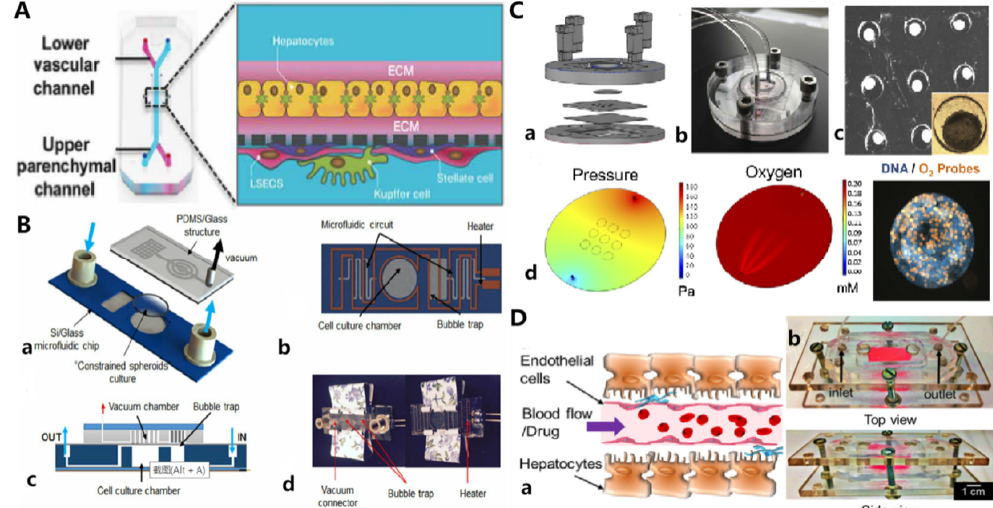
Figure 1. A liver chip system for drug toxicity testing. ( A ) Specific cell type (human, dog, rat) four-cell culture chip used for drug toxicity test [66]; ( B ) Perfusion-incubator-liver-chip (PIC)